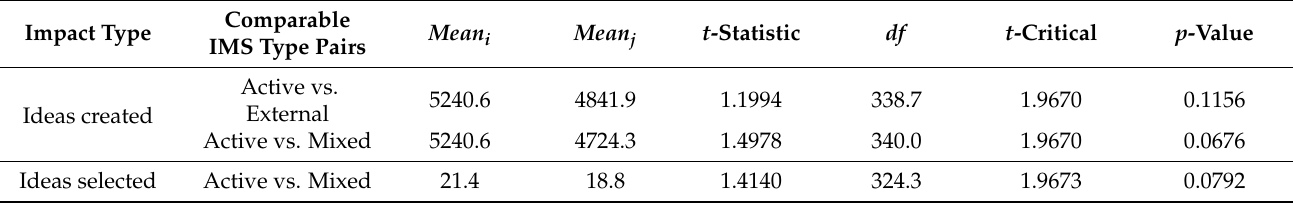
Table 12. Hypothesis test statistics for mixed rewards impact by IMS types.